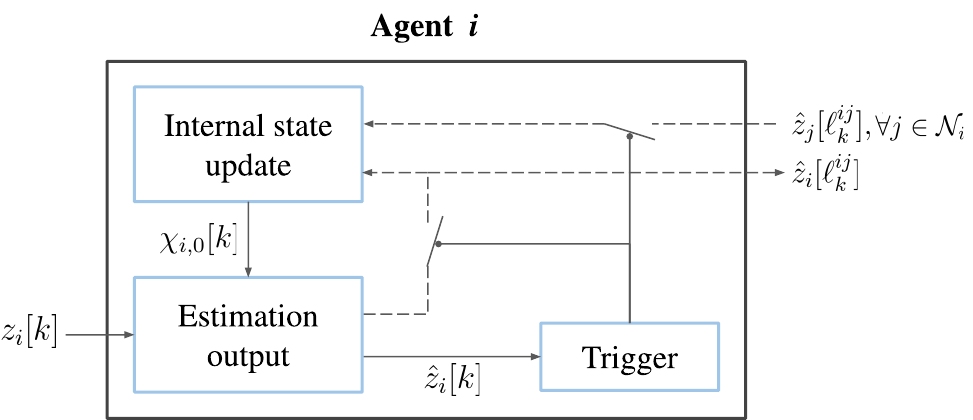
Figure 1. Block diagram for each agent i ∈ V . The internal states that the agent computes are updated using the last transmitted estimates of the agent and its neighbours j ∈ N i , which are denoted by ] and ˆ z [ (cid:96) ij ] , respectively. The current estimate ˆ z ˆ z i [ (cid:96) ij j k k and the local signal z i [ k ] . This estimate is evaluated by the event trigger, which decides if the current value should be transmitted to the